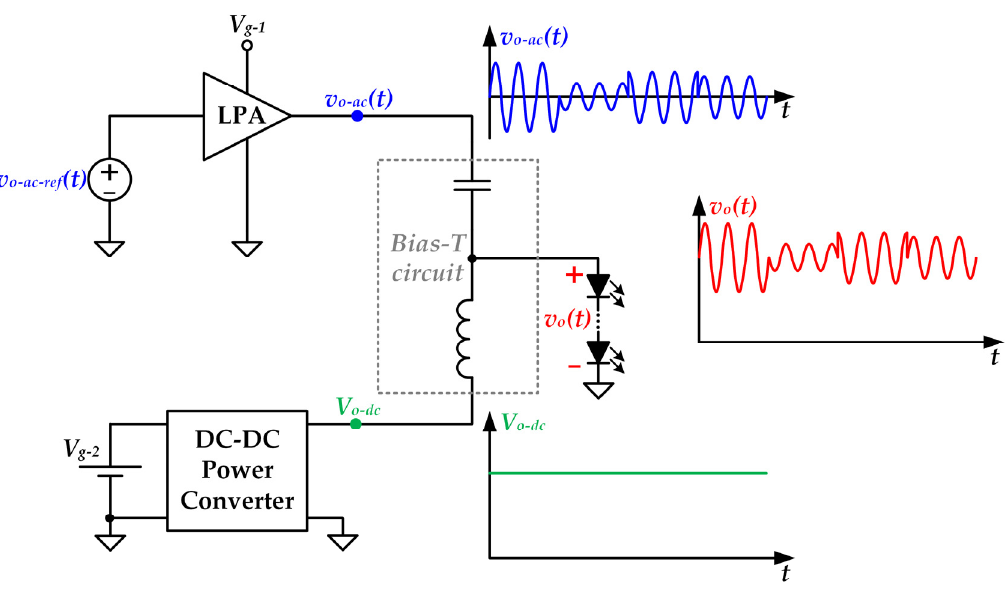
Figure 1. VLC driver based on the use of a DC-DC power converter, a LPA and a bias-T